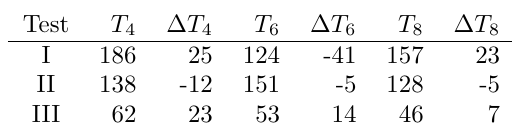
Table 13: Time-constants found from experiments (mean value of T a,i and T d,i in Table 11) for the different test cases and number of pro- pellers. ∆ T i is the time difference (in ms) between T i and the time-constant estimates based on eq.